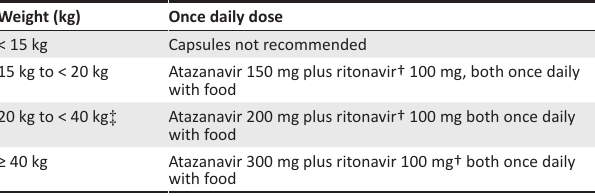
TABLE 2-A1: Atazanavir capsules. Weight